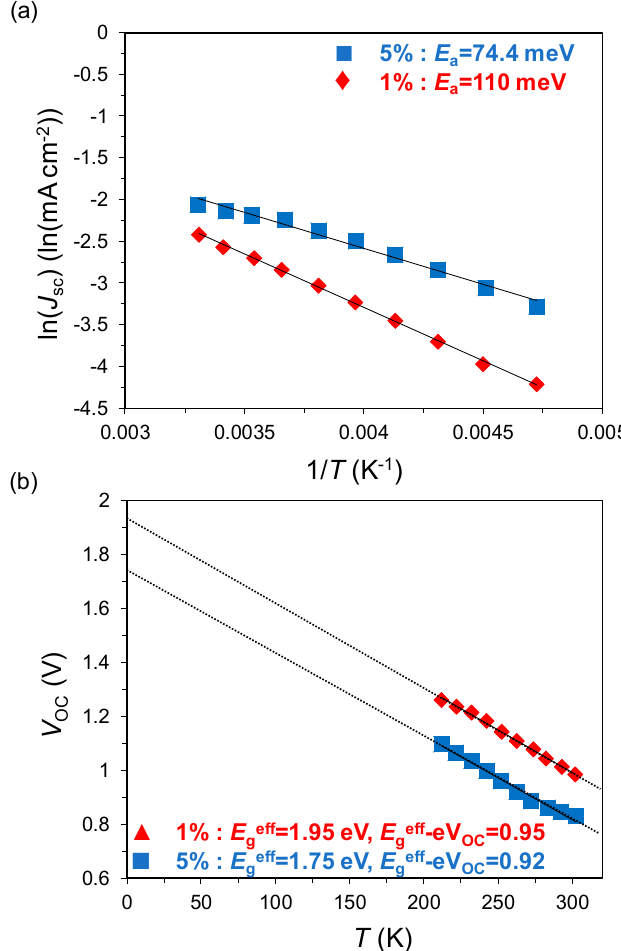
Figure 2. Temperature dependence of ( a ) J SC and ( b ) V OC for the 1% doped (red) and 5% doped (blue) pn- homojunction devices.